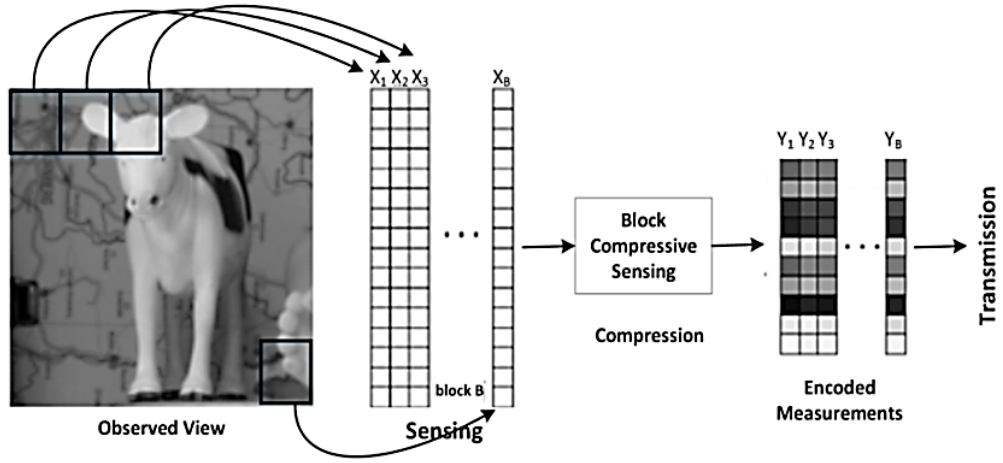
Figure 6. Encoding process of BCS .